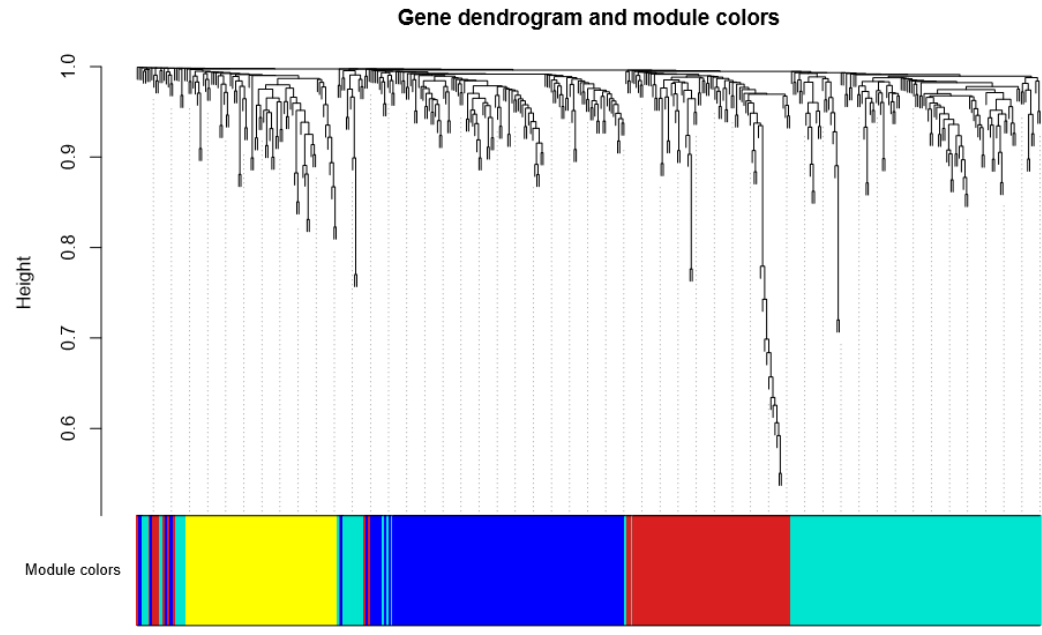
Figure 2. The gene dendrogram and the corresponding module colors. The upper section is the dendrogram of differentially expressed genes, a hierarchical cluster tree showing co-expression modules identified by weighted gene co-expression network analysis (WGCNA). Each leaf in the tree is one gene. The lower section indicates the modules of co-expressed genes, each color represents a different module and each module contains genes with similar expression patterns.